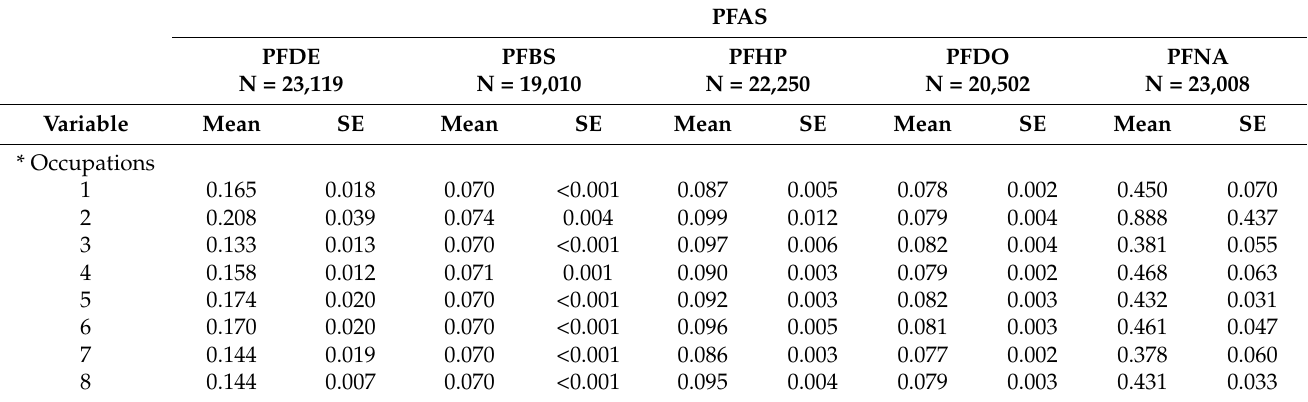
Table 1. Summary mean differences in participants’ serum PFAS (PFDE, PFBS, PFHP, PFDO, PFNA) concentrations (ng/mL) according to occupational